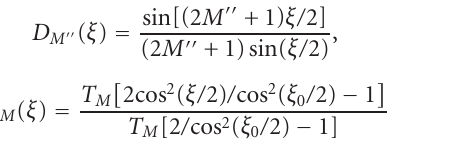
Figure 1: Spherical scanning for a quasiplanar antenna.